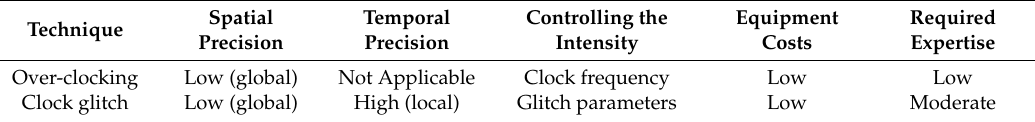
Table 1. Clock fault injection techniques and characteristics.